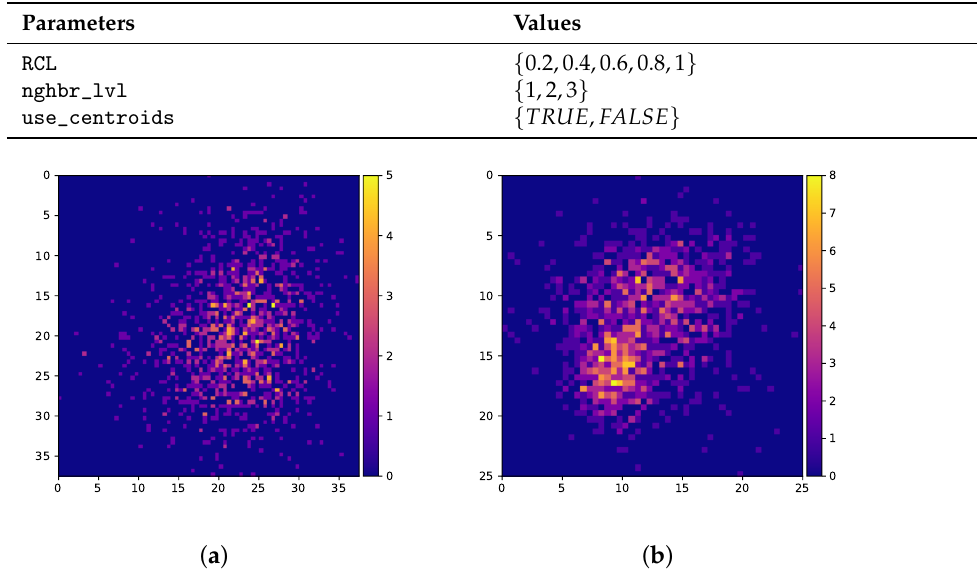
Table 3. GRASP parameters and their considered values.